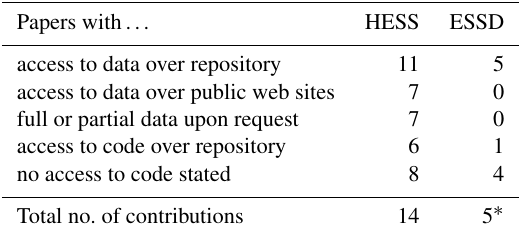
Table 1. Overview of access to data and code for the studies in this special issue. ∗ Three articles have companion papers in both jour- nals. Some studies link to more than one data source. Completeness of provided data and code is not considered. Papers